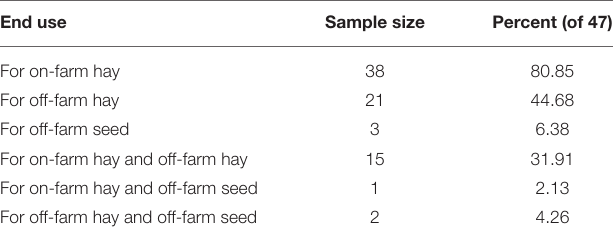
TABLE 4 | Alfalfa end use of famers who have tried biological control, n =